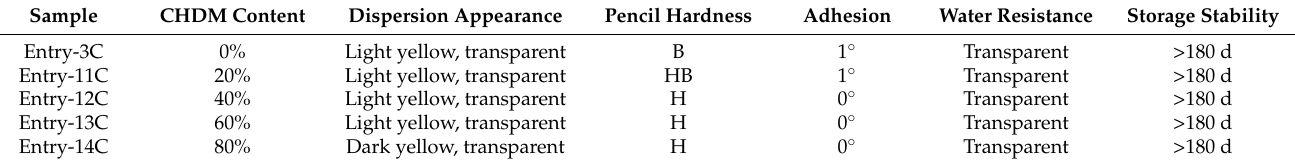
Table 4. The properties of NWCPE dispersions and cured films with different CHDM dosage.